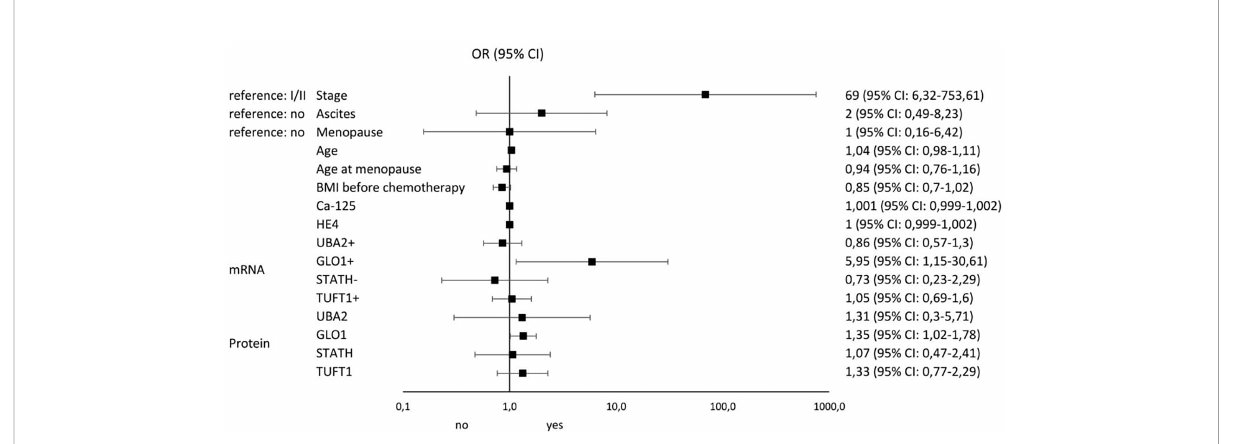
FIGURE 4 Results of univariable logistic regression analysis - odds ratio (OR) and its 95% con fi dence interval (95% CI) for the relationship between the occurrence of chemotherapy resistance (no/yes) and particular classi fi cation variables in group A of patients with histopathologically con fi rmed diagnosis of stage I-IV ovarian cancer, treated with surgery and supplemented with chemotherapy as per – tandard guidelines.